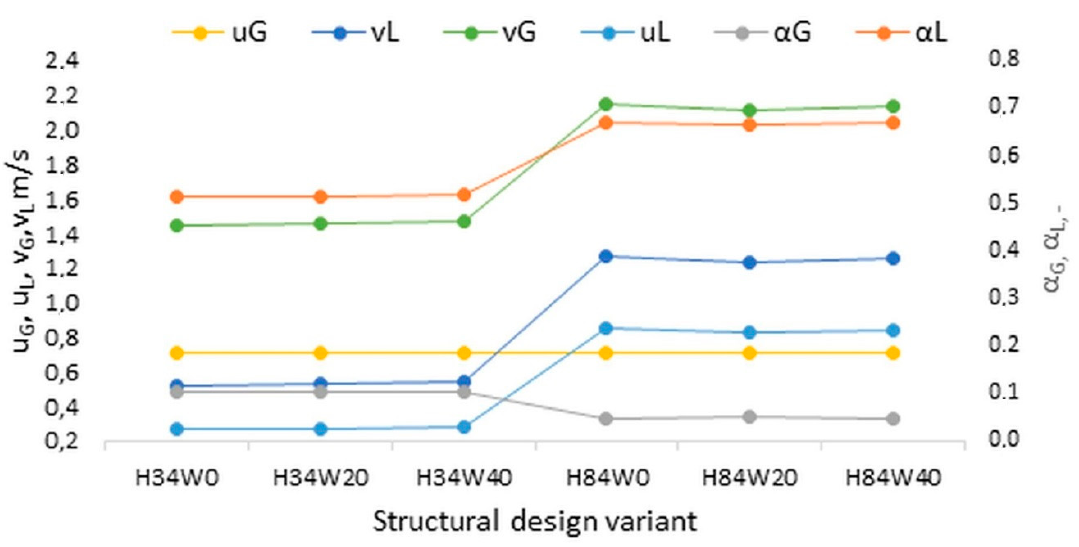
Figure 4. Superficial velocity, real velocity, and gas/liquid holdup in mixture for different variants of the reactor design: α G —gas holdup for ALR, α L —liquid holdup for ALR, u G —superficial gas velocity in the mixture for ALR, u L —superficial liquid velocity in the mixture for ALR, v L —real liquid velocity in the mixture, v G —real gas velocity in the mixture.